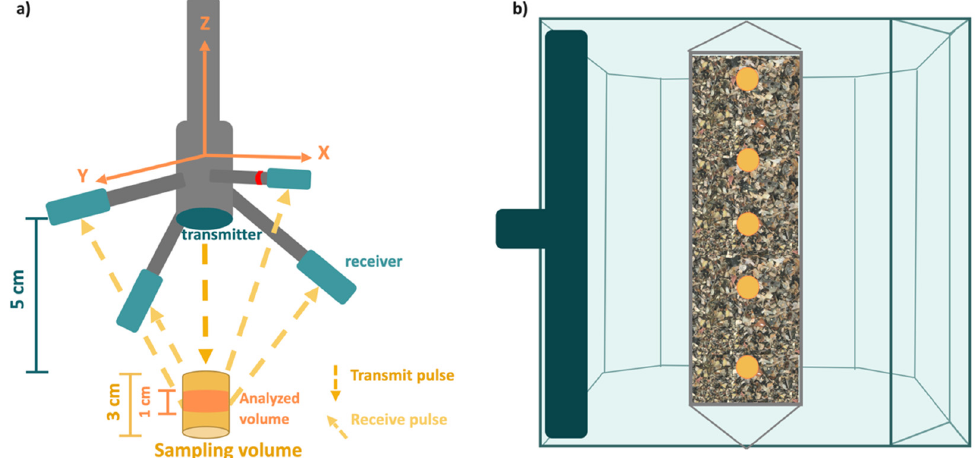
Figure 5. Screening substrates based on their ability to affect current velocity. ( a ) Illustration of Nortek Vectrino profiler probe head with the process of 3 D velocity measurement. The position of the probe sampling volume is highlighted in yellow, and the position of the analysed volume in the screening test is highlighted in orange. ( b ) Top-view illustration of the tank with the five ADV probe positions above the gutter indicted by yellow circles (5, 14, 23, 31 and 40 cm).